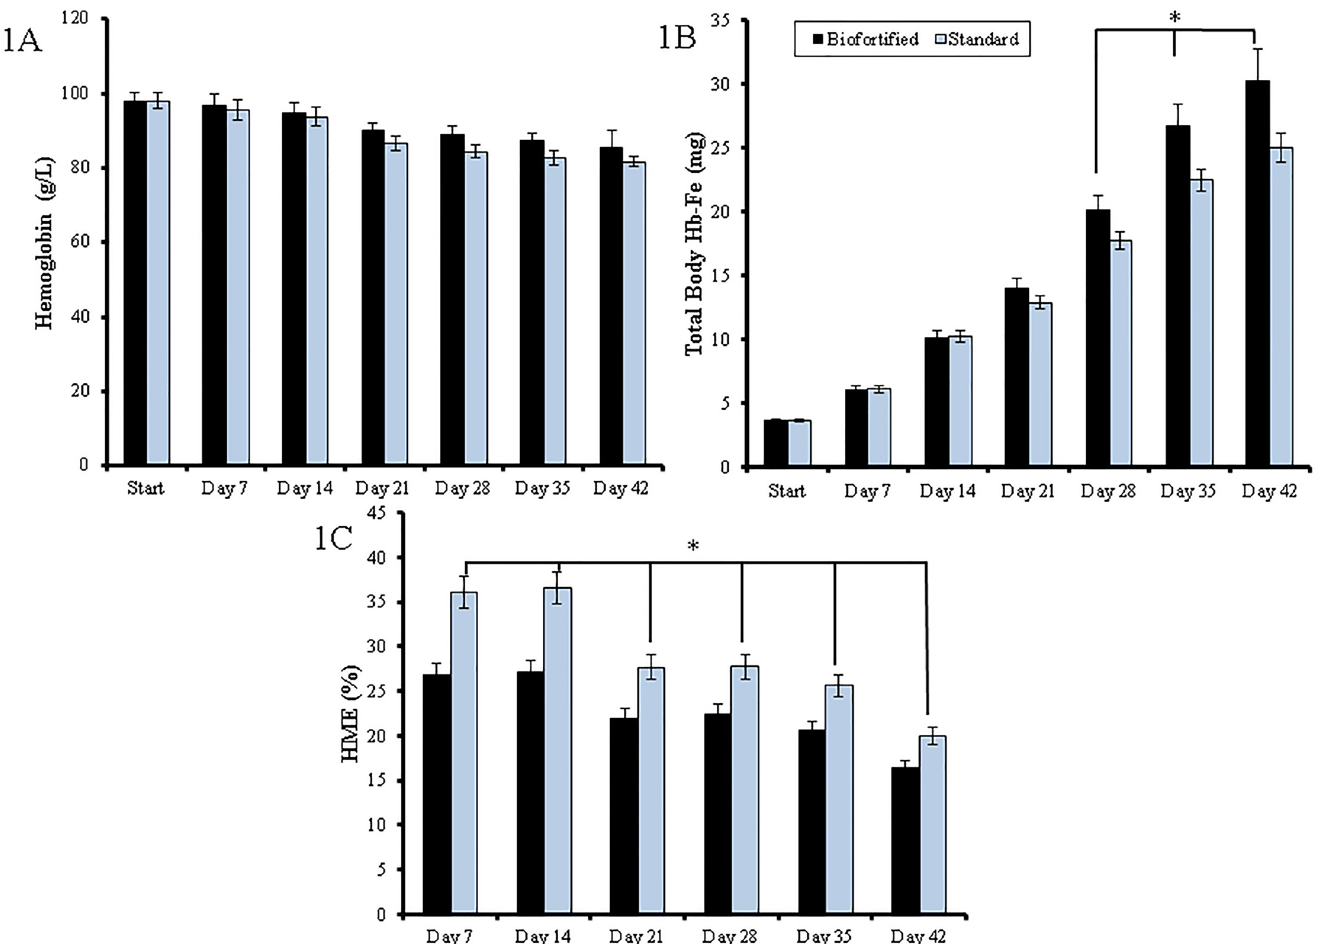
Fig 1. Fe-related parameters assessed during the study. (1A) Blood hemoglobin concentration (g/L), (1B) Total body Hb-Fe (mg), (1C) Hemoglobin maintenance efficiency (%). * P < 0.05 between treatment